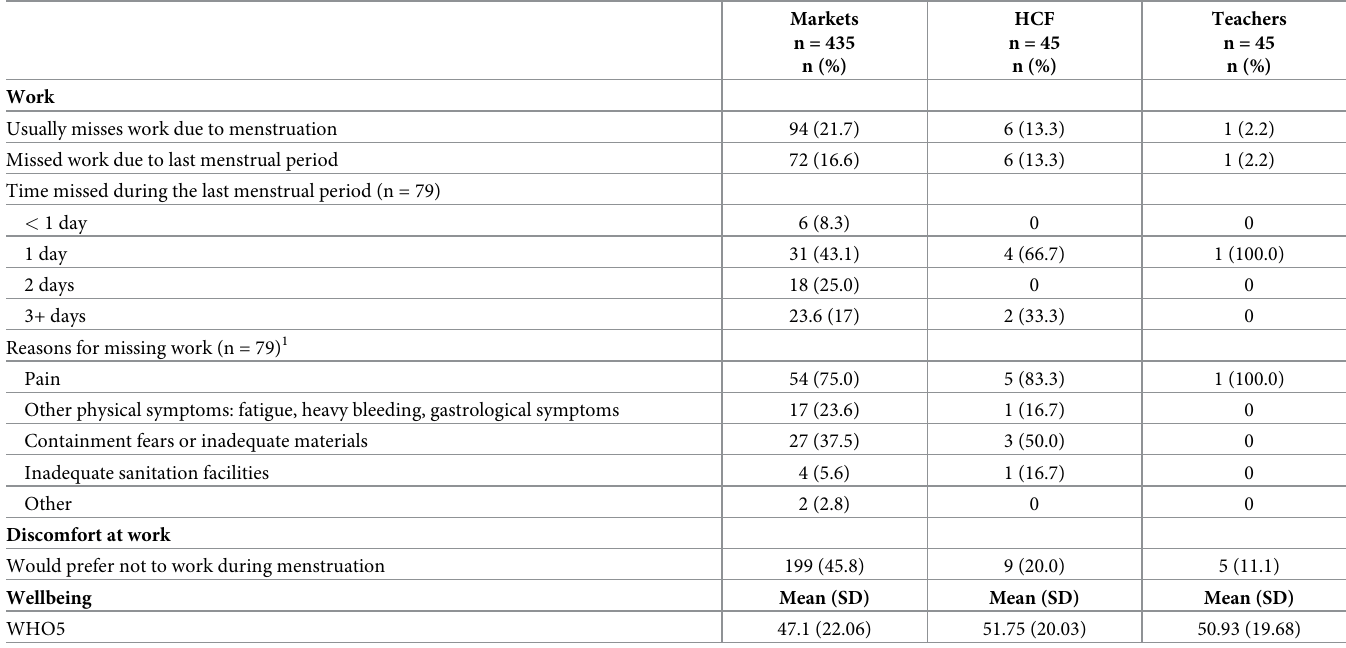
Table 3. Prevalence of self-reported consequences for women’s work and